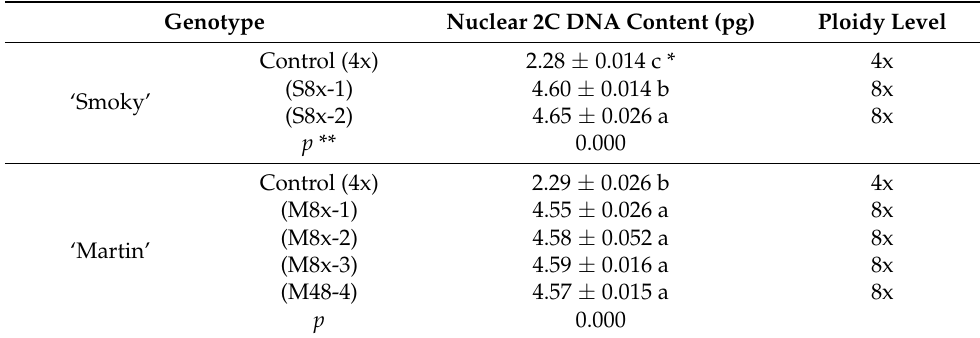
Table 2. Nuclear DNA content and ploidy level of Amelanchier alnifolia cvs. ‘Smoky’ and ‘Martin’ control tetraploid plants and their octoploid clones